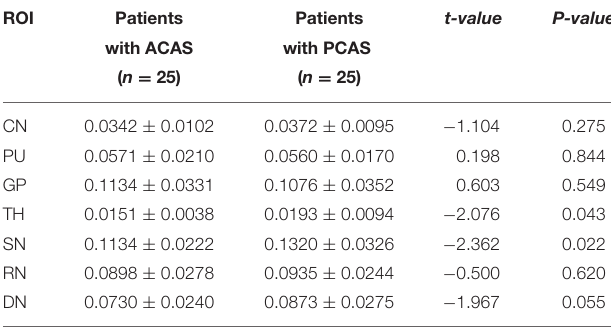
TABLE 4 | Susceptibility (ppm) comparisons in gray matter nuclei between patients with ACAS and PCAS.